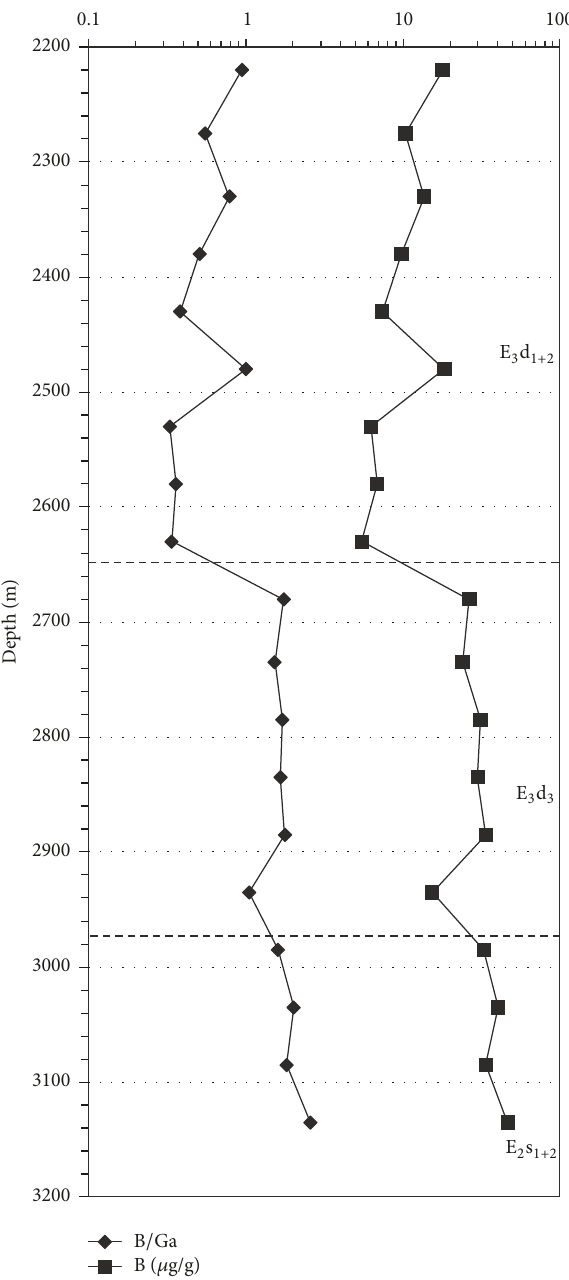
Figure 9: Plots showing the variations in the concentrations of B element and the ratio of B/Ga with depth in mudstone of well BZ-1. B = boron; Ga =